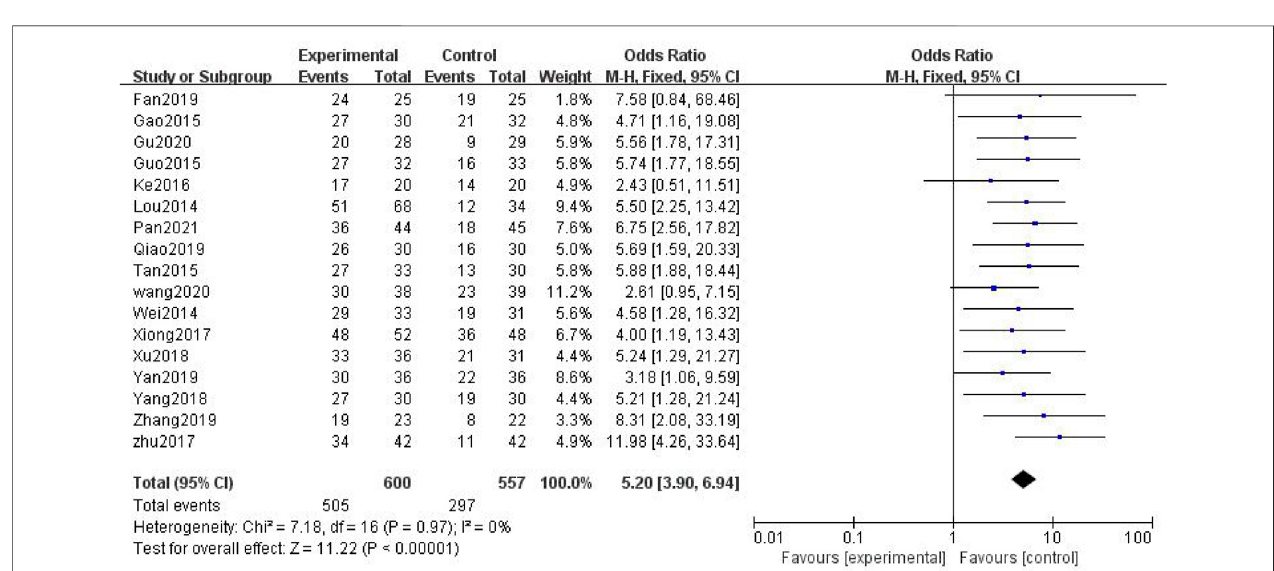
FIGURE 5 | Overall response